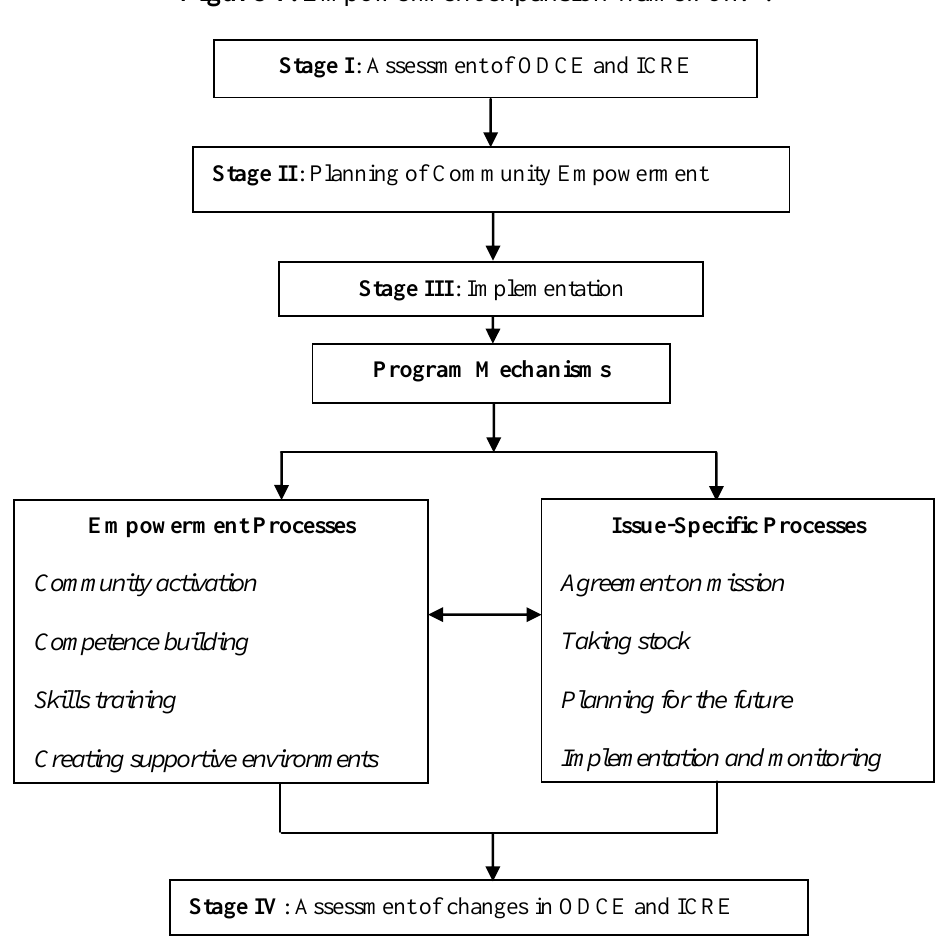
Figure 1. Empowerment expansion